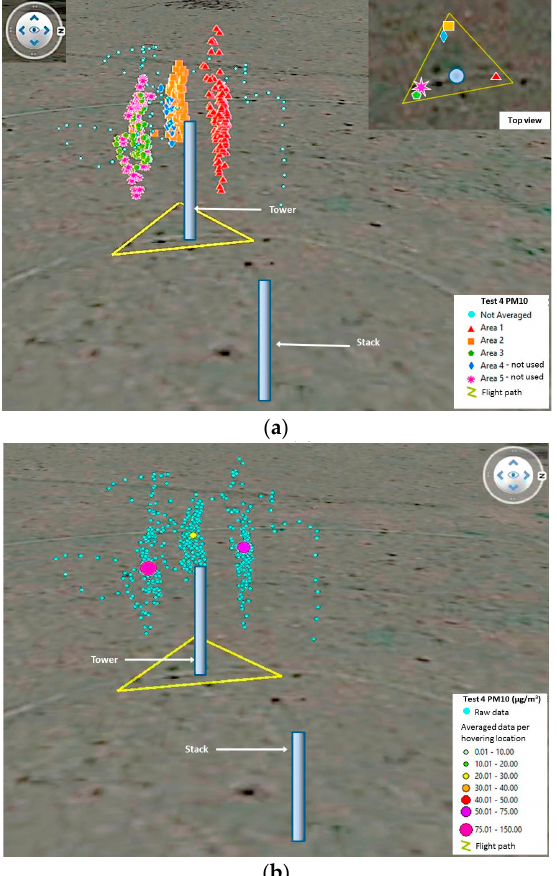
Figure 21. 3D visualization for Test 4, showing ( a ) the waypoints grouped per high density areas; and ( b ) the raw data and way points used once averaged per area.